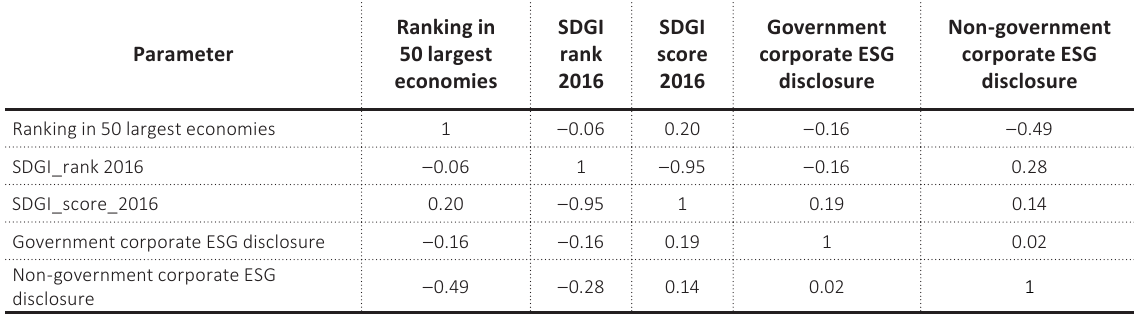
Table D2. Correlation analysis of ESG disclosure regulation and rankings: case of developed countries